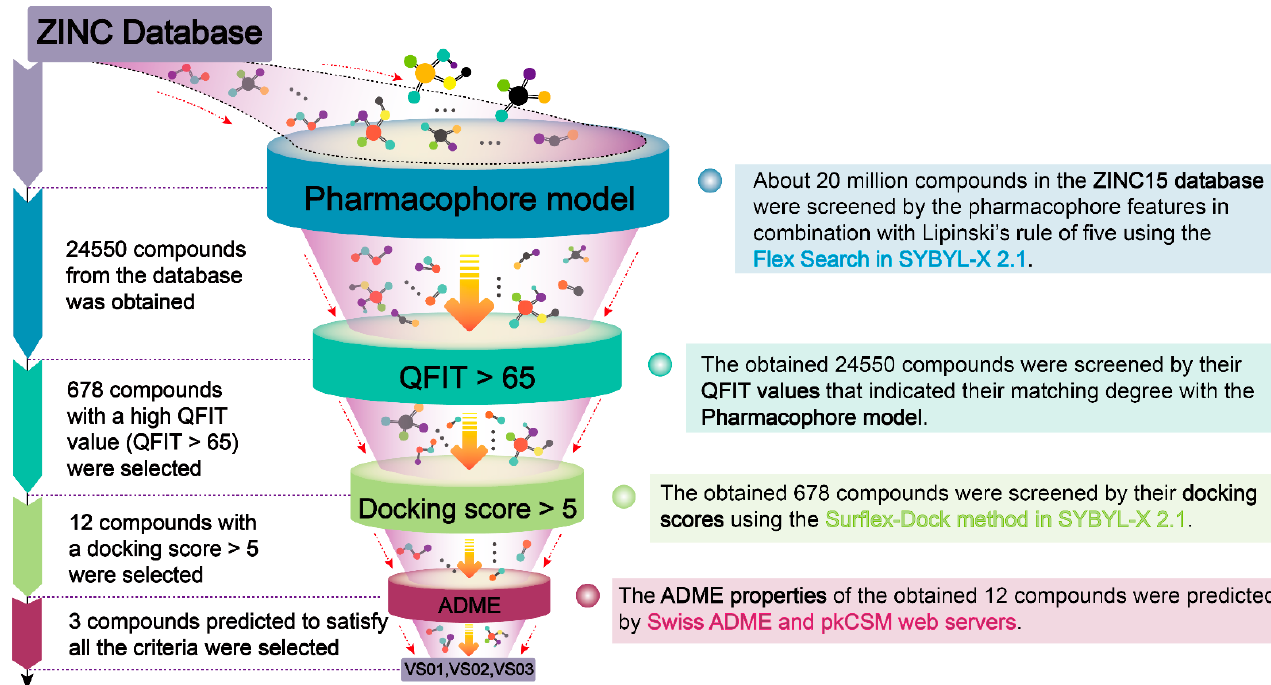
Figure 5. Four rounds of screenings in the virtual screening process.